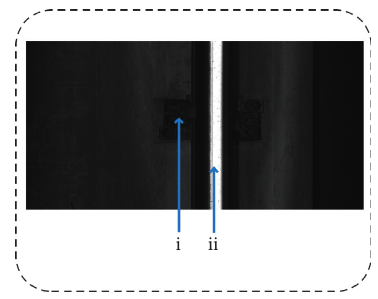
Figure 5: Original track image: (i) fastener and (ii) rail.